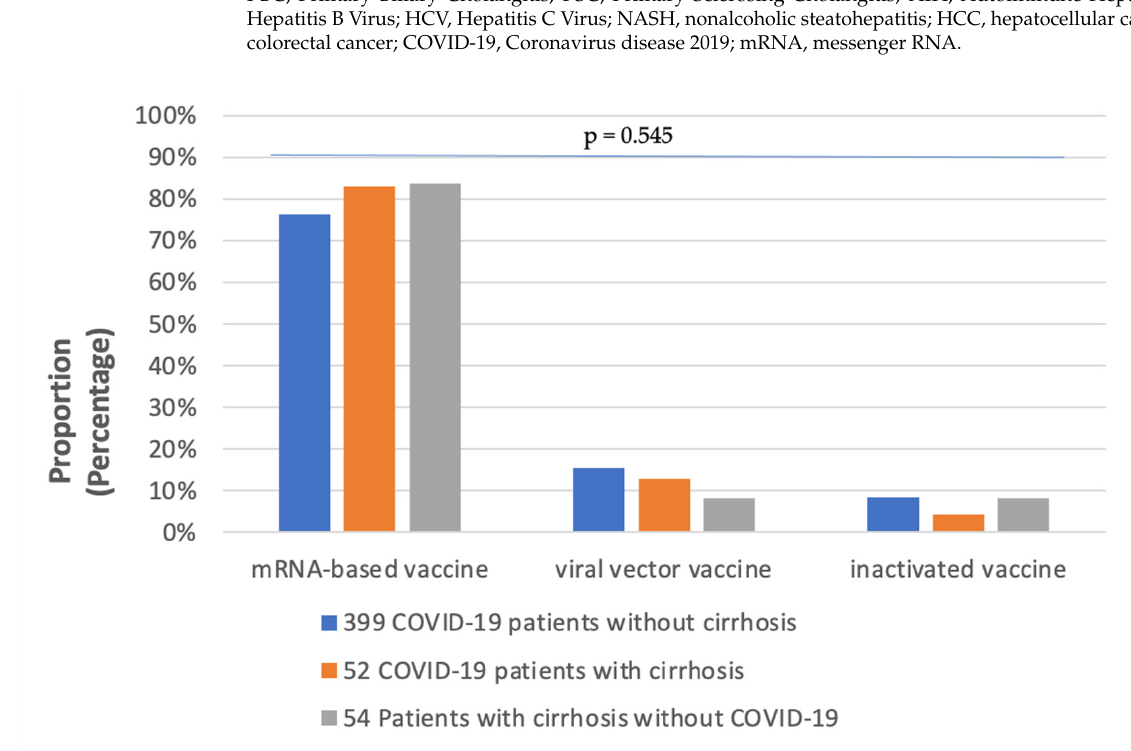
Figure 2. The rates of patients receiving different COVID-19 vaccines in the 3 groups.